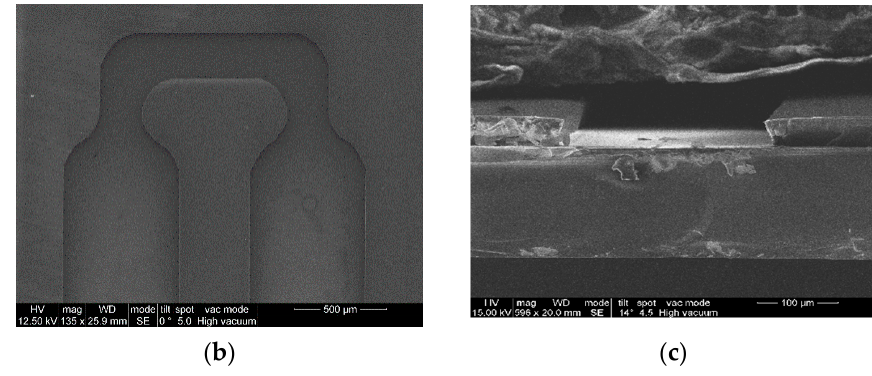
Figure 6. Images of microfluidic systems formed using SU-8 photoresist: ( a )—general view of the microfluidic system, ( b )—SEM-image of the detection zone section, ( c )—SEM-image of the microfluidic channel